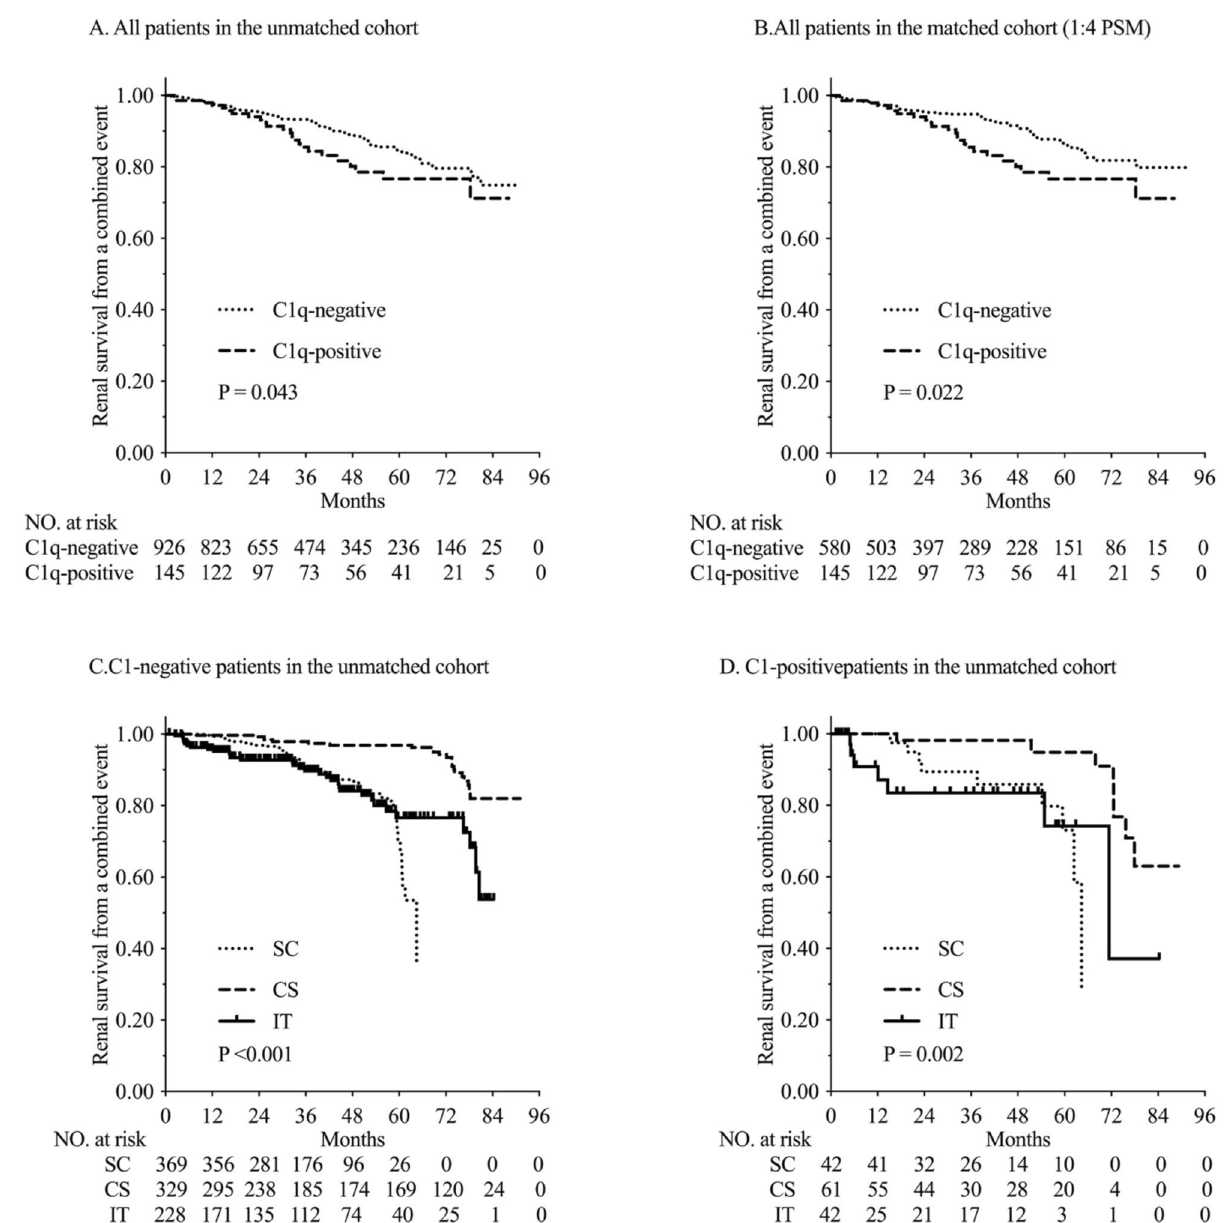
Figure 3. Kaplan–Meier analysis for the probability of composite